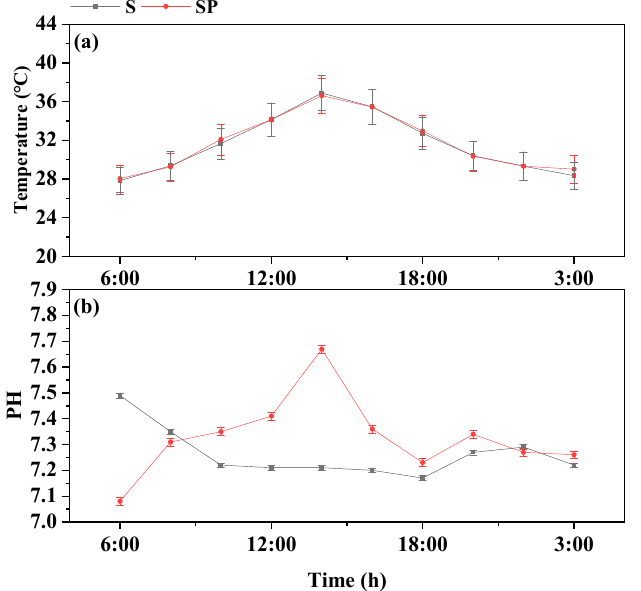
Figure 3. Diurnal variation of the water PH and temperature in the agricultural drainage ditch. ( a ) the water temperature; ( b ) PH value of water.